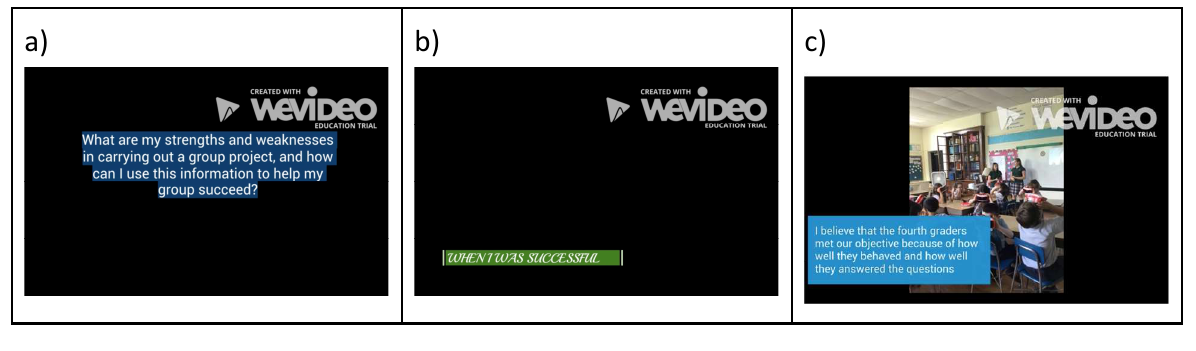
Figure 5: Use of text and titles in Digital Stories; (a) Question text to create segments in Clara’s Digital Story, (b) Statement text to create segments in Gabby’s Digital Story, (c) Text on screen to impart information in Nancy’s Digital